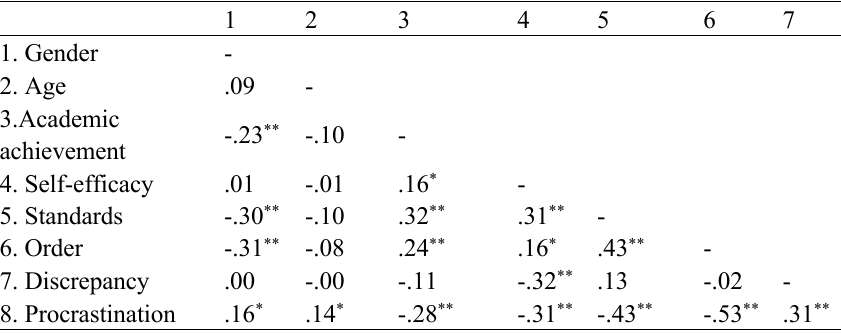
Table 2. Correlations